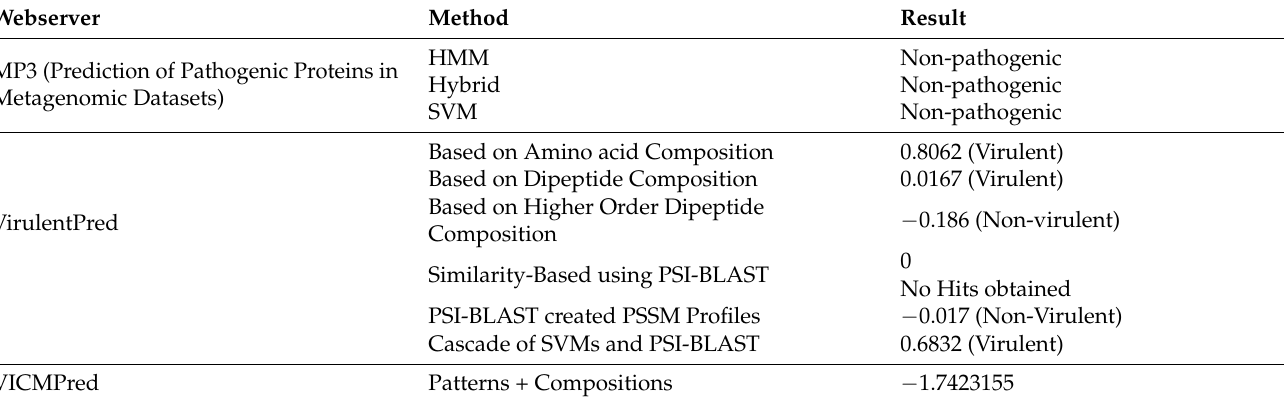
Table 2. The predicted virulence factor of chromate reductase from P. alcalifaciens